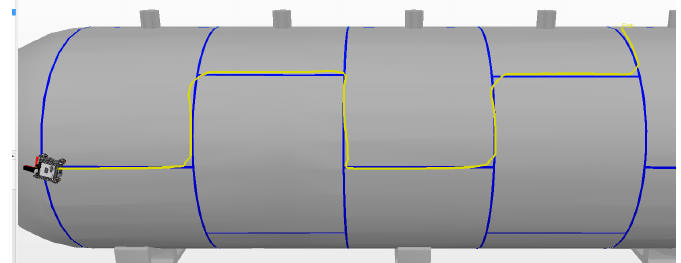
Figure 25. Experiment performed with Autonomous